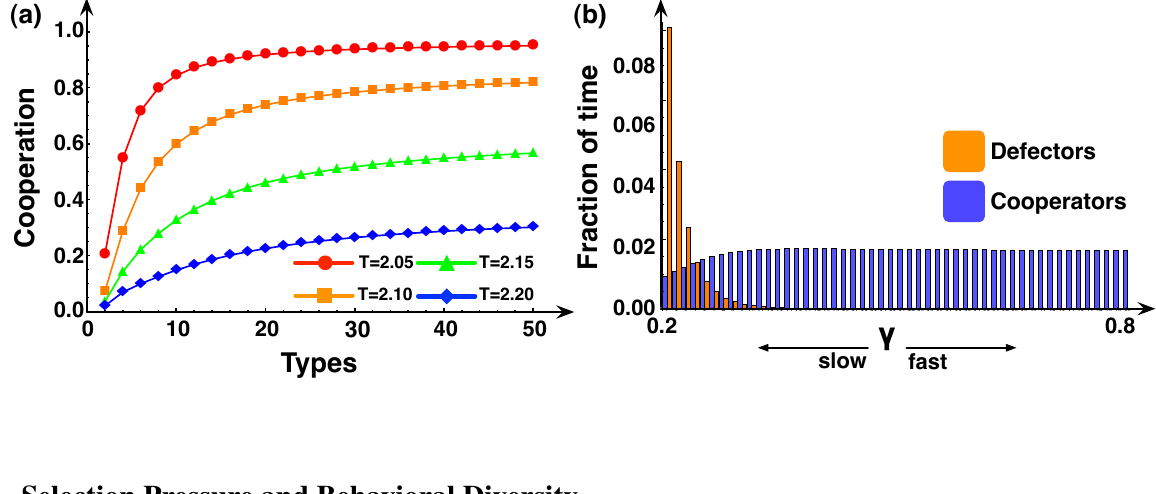
Figure 5. Cooperation and behavioral diversity. (a) The population spends more time in a cooperative state (of any type) when the number of possible types ( M ) increases, irrespective of the temptation to defect T in the PD. ( N =100, β =0.1, c =0.16, δ =0.3 , R =2, P =1, S = 3 − T ) (b) While the majority of cooperator types is equally represented, only the slower types of defectors manage to survive. The defector population exhibits behavioral differences, which inhibits the dominance of slowest defector type, providing an escape hatch for cooperation to thrive ( M =50, T =2.1, R =2, P =1, S =0.9). Figure reproduced from